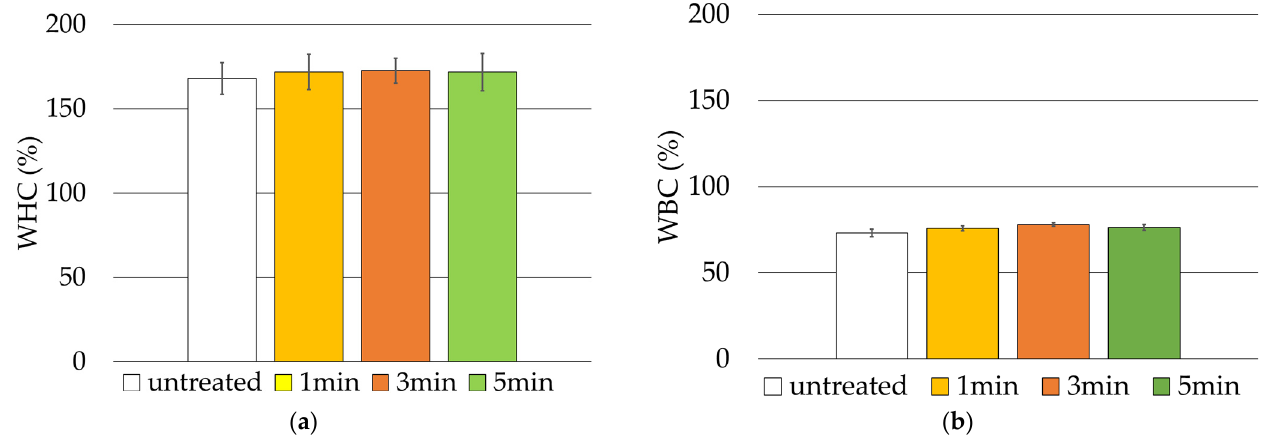
Figure 4. Change in the water-holding ( a ) and water-binding ( b ) capacity of wheat flour (type 550) as a function of NTP treatment time.